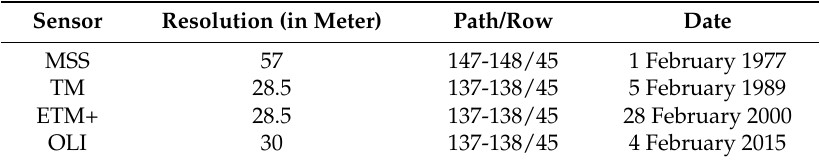
Table 1. Information of Landsat data used to map mangrove cover at the species level in the Sundarbans.